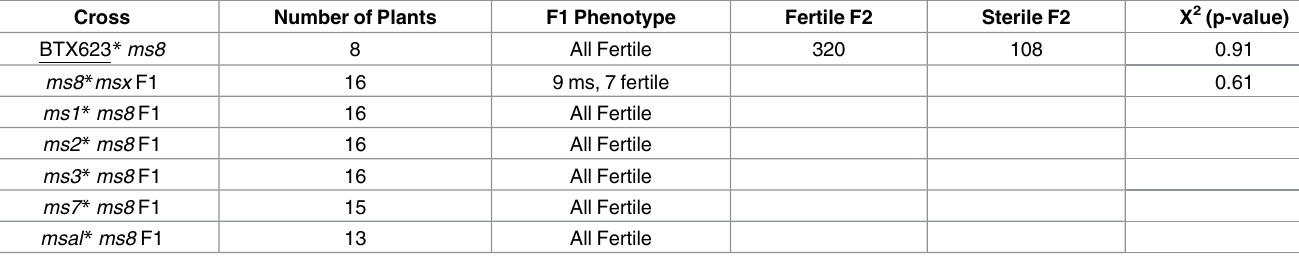
The ms8 male sterility was mediated by a novel recessive mutation in a nuclear